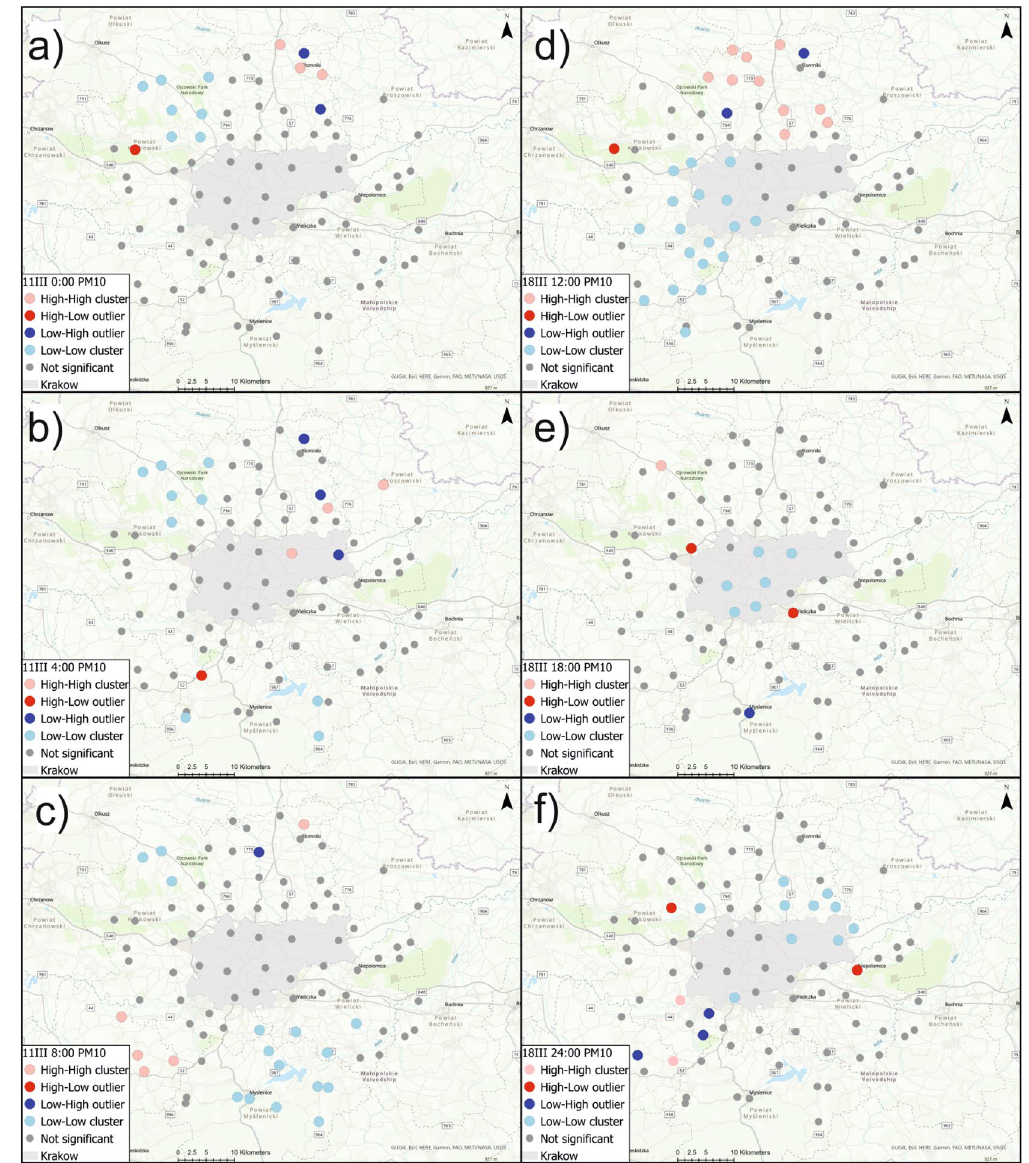
Figure 7. Local Moran’s I cluster maps showing high-high, low-low, low-high, and high-low spatial associations for PM10 concentration on March 11th and March